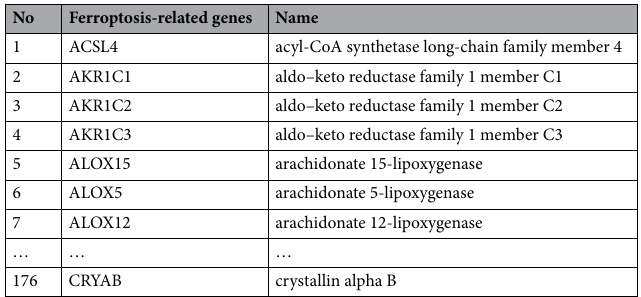
Table 2. Ferroptosis related genes. Due to space reasons, only some genes are listed. For detailed information, see Table 2.xlsx in the supplementary.